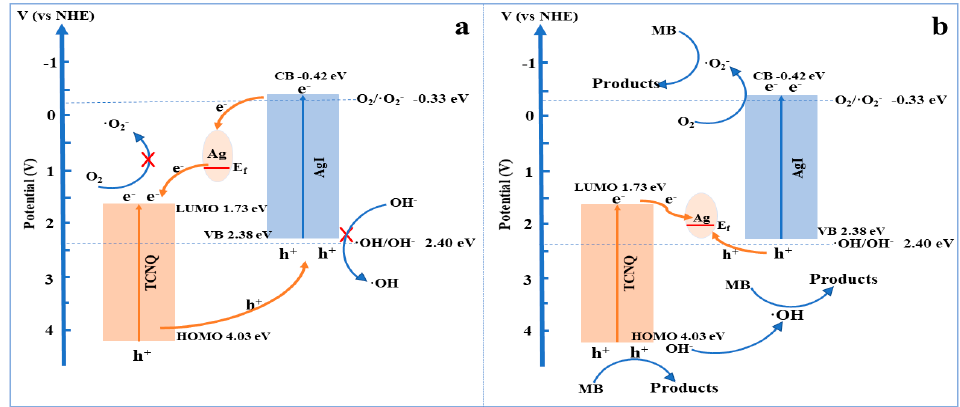
Scheme 1. Schematic diagram of photogenerated charge separation and degradation mechanism: ( a ) traditional model and ( b ) Z-scheme system.